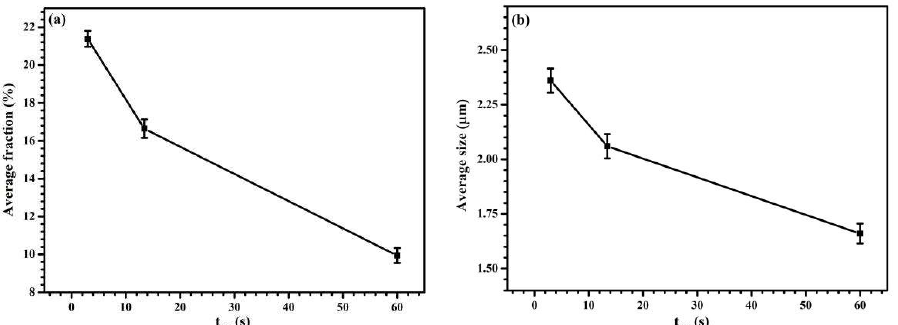
Figure 7. Fraction ( a ) and size ( b ) of M/A constituents in the simulated ICCGHAZs with different cooling rates.